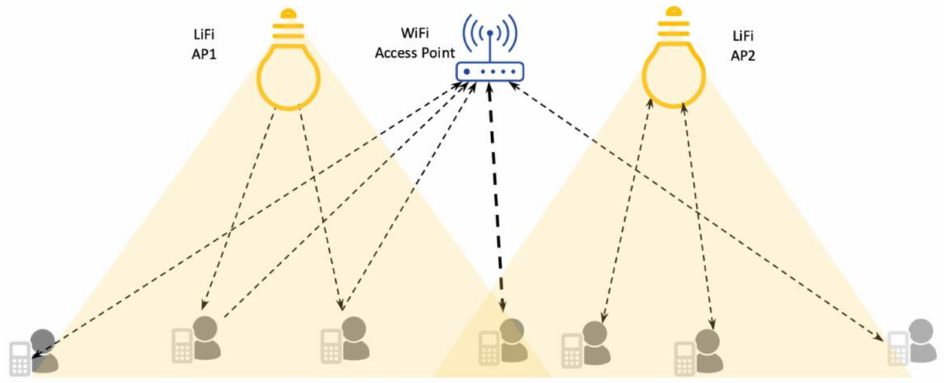
Figure 1. Hybrid light fidelity/wireless fidelity (LiFi/WiFi)